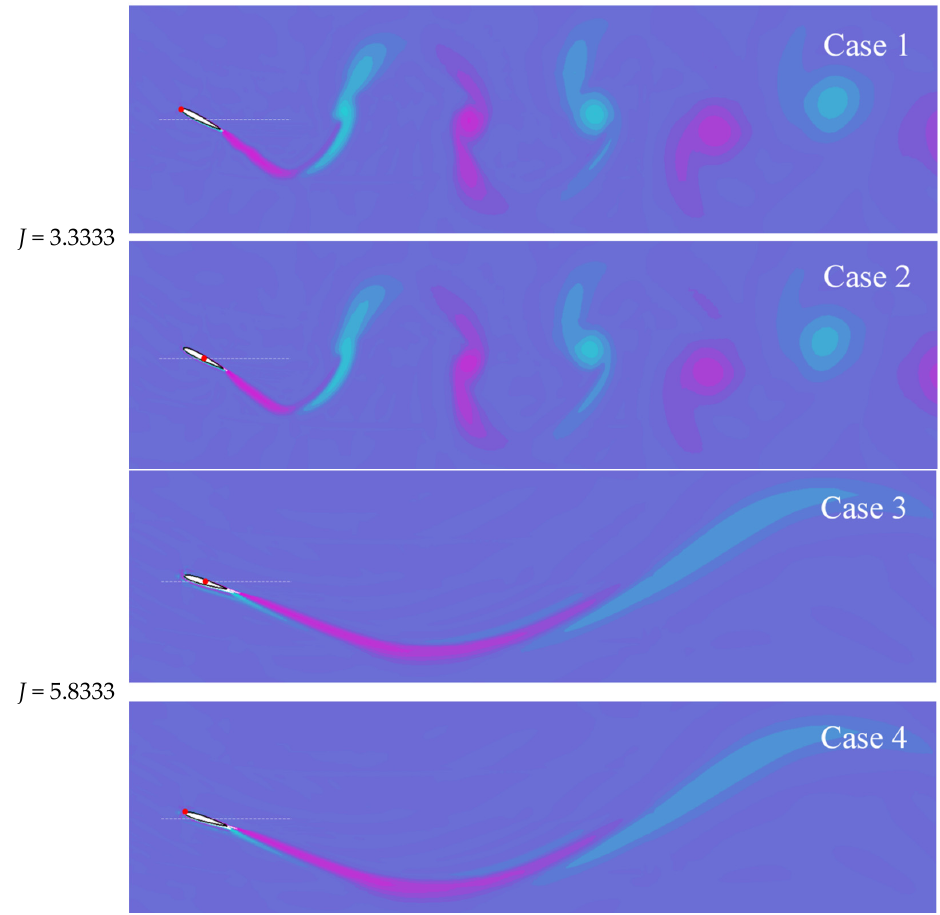
Figure 17. Comparison of wake vortices under four verification conditions (when the midpoint of the airfoil is at the equilibrium position).